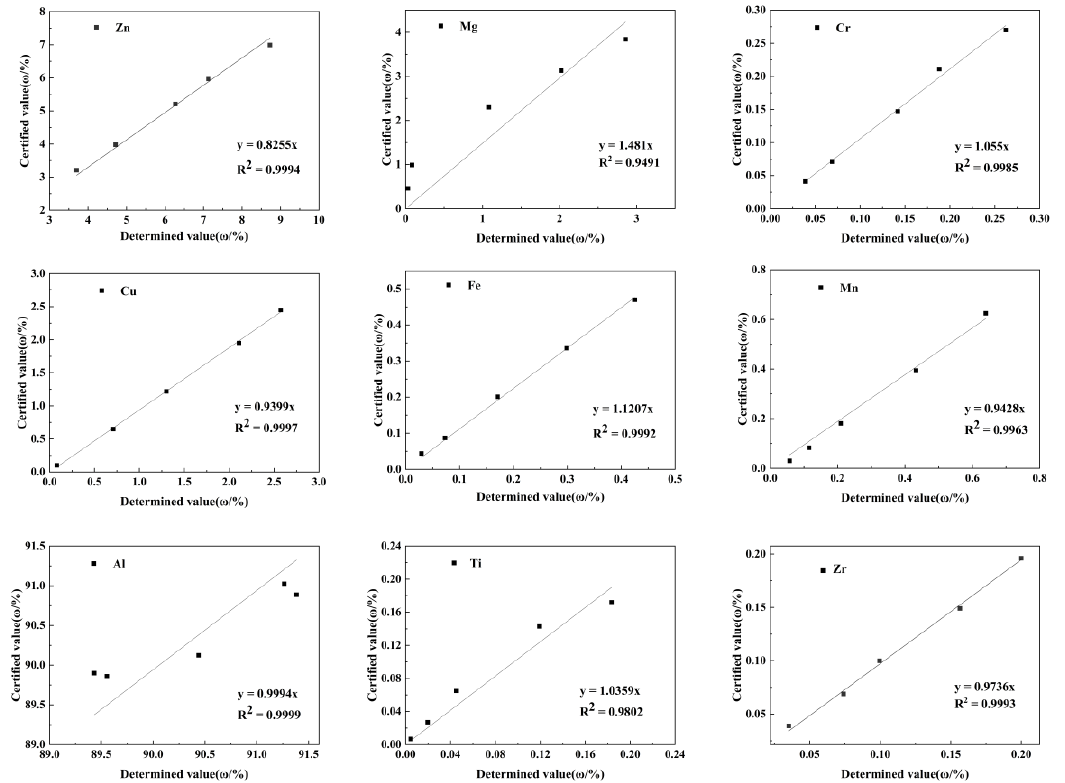
Figure 6. Linear fitting diagram of the μ -XRF measured value and certified value of the aluminum alloy standard sample.